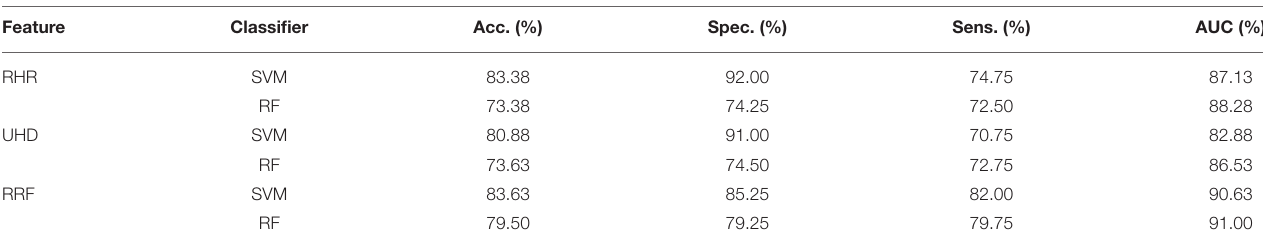
TABLE 3 | Results of the proposed features in video